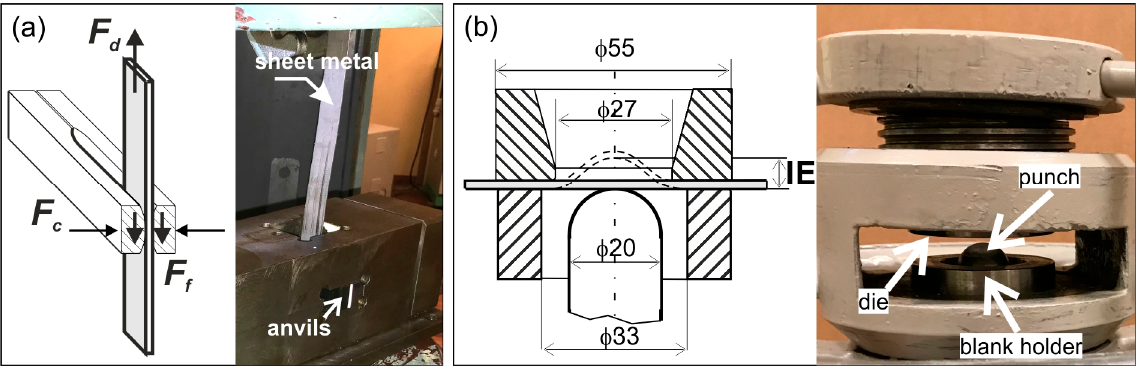
Figure 1. Experimental tests: ( a ) the strip drawing test ( F d —drawing force, F c —clamping force, and F f —frictional force); ( b ) the Erichsen cupping test.